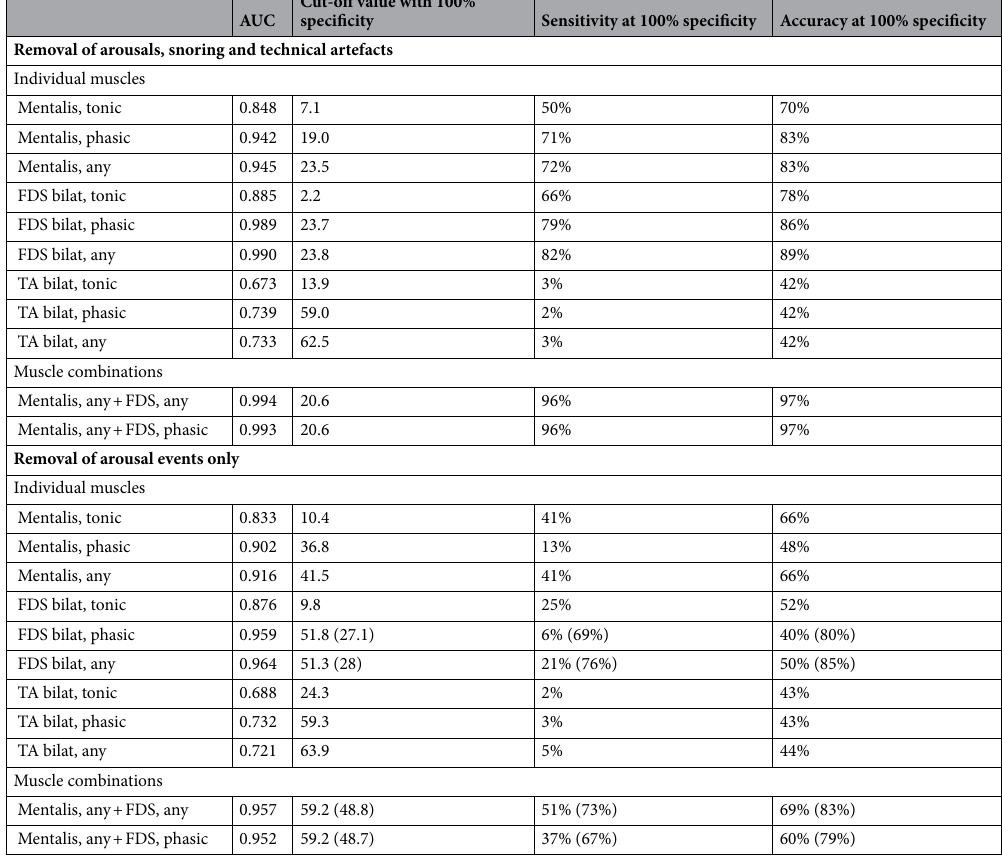
Table 5. Metrics of the accuracy of RBDtector . AUC area under the curve, bilat bilateral, FDS flexor digitorum superficialis muscle, TA tibialis anterior muscle. Values in parentheses represent cut-off values after the exclusion of a single RBD-negative subject, which exhibited technical artefacts on both FDS channels (example given in Figure